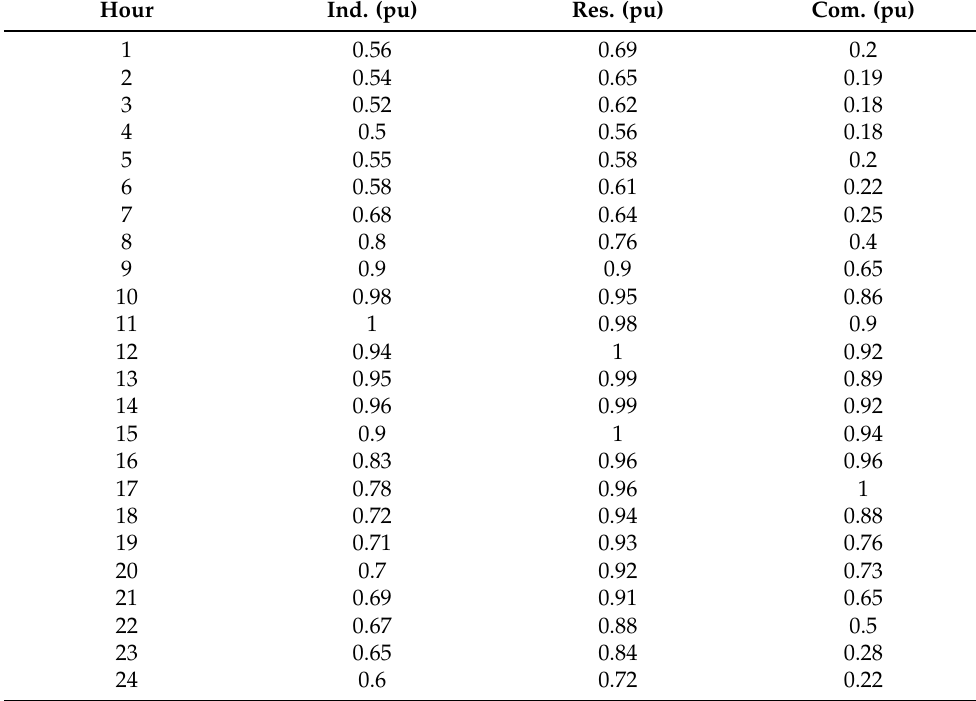
Table 3. Load consumption profiles per user type: residential (Res.), industrial (Ind.), and commercial (Com.). Hour Ind. (pu) Res. (pu) Com. (pu) 1 0.56